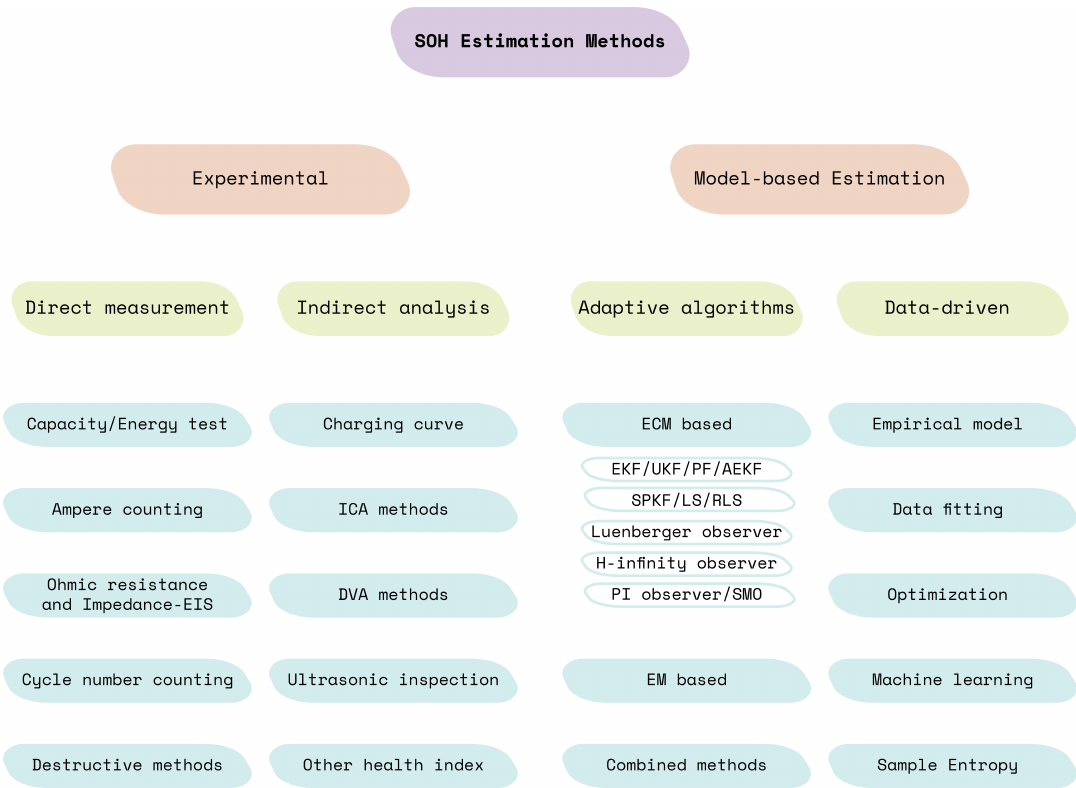
Figure 1. Classification of battery SOH estimation